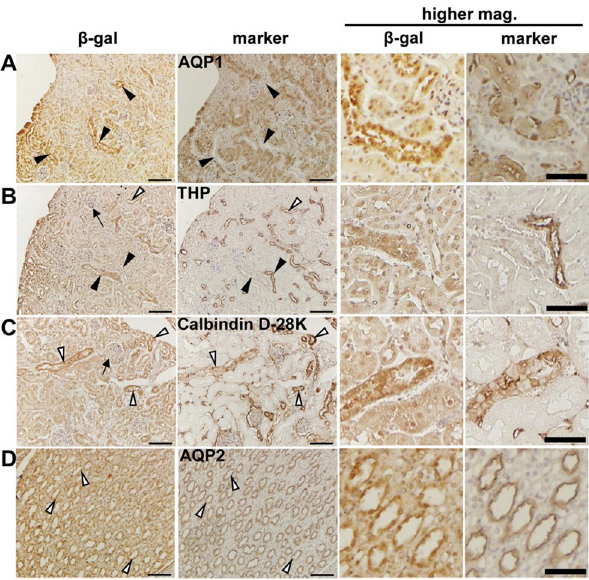
Fig 1. The localization of TMOD1 in mouse kidney. Immunohistochemistry was performed on the consecutive renal sections of Tmod1 + /lacZ mice using anti- β -gal antibody (indicating TMOD1) and antibodies for markers of different tubular segments. (A) AQP1 for proximal tubule; (B) THP for ascending thick limb of Henle’s loop; (C) Calbindin D- 28K for distal convoluted tubule; (D) AQP2 for collecting ducts. White and black arrow heads indicates positive and negative colocalization of β -gal and the markers, respectively. Arrows in (B) and (C) points to a glomeruli. Images with higher magnification were shown on the right panels. Scale bars: 100 μ m (for lower mag. images) and 50 μ m (for higher mag.